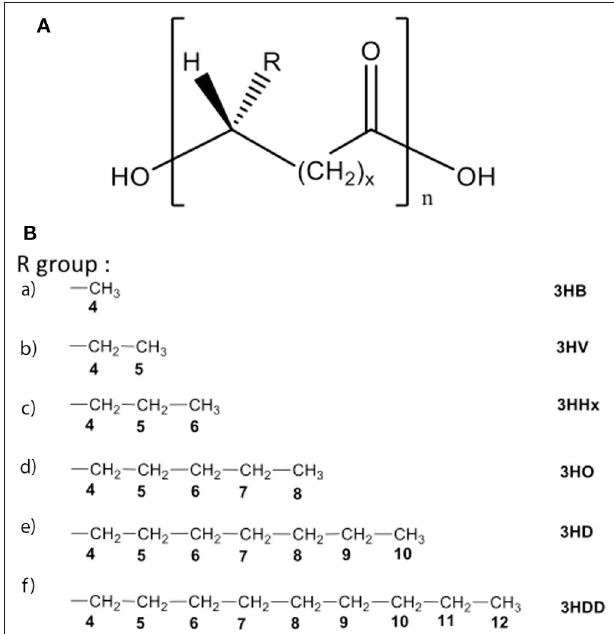
FIGURE 9 | (A) The general structure of PHAs. (B) The R groups of various PHAs that have been utilized in cardiac tissue engineering. The short chain length PHAs (SCL-PHAs); monomers include 3HB: 3-hydroxybutyrate and 3HV: 3-hydroxyvalerate whilst for medium chain length PHAs (MCL-PHAs) that have been investigated monomers include 3HHx: 3-hydroxyhexanoate, 3HO: 3-hydroxyoctanoate, 3HD: 3-hydroxydecanoate and 3HDD: